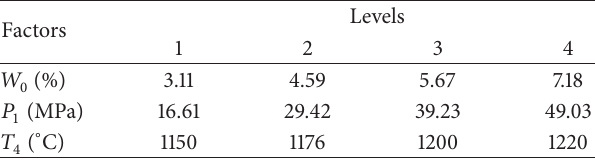
Table 3: Factor levels of processing parameters: powder moisture ( 𝑊 0 ), compaction pressure ( 𝑃 1 ), and firing temperature ( 𝑇 4 ).